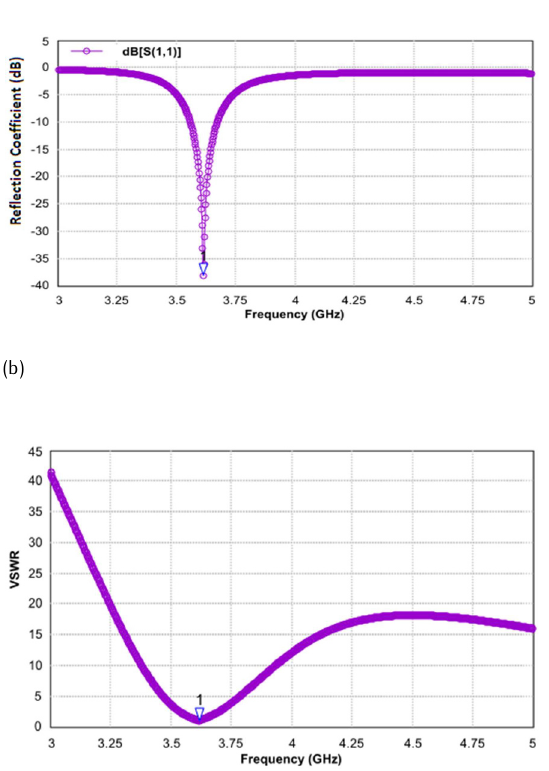
Figure 2. (a) Simulated reflection coefficient ( S 11 ) of hexagonal antenna geometry as a function of frequency (GHz); (b) Simulated VSWR of hexagonal antenna geometry as a function of frequency